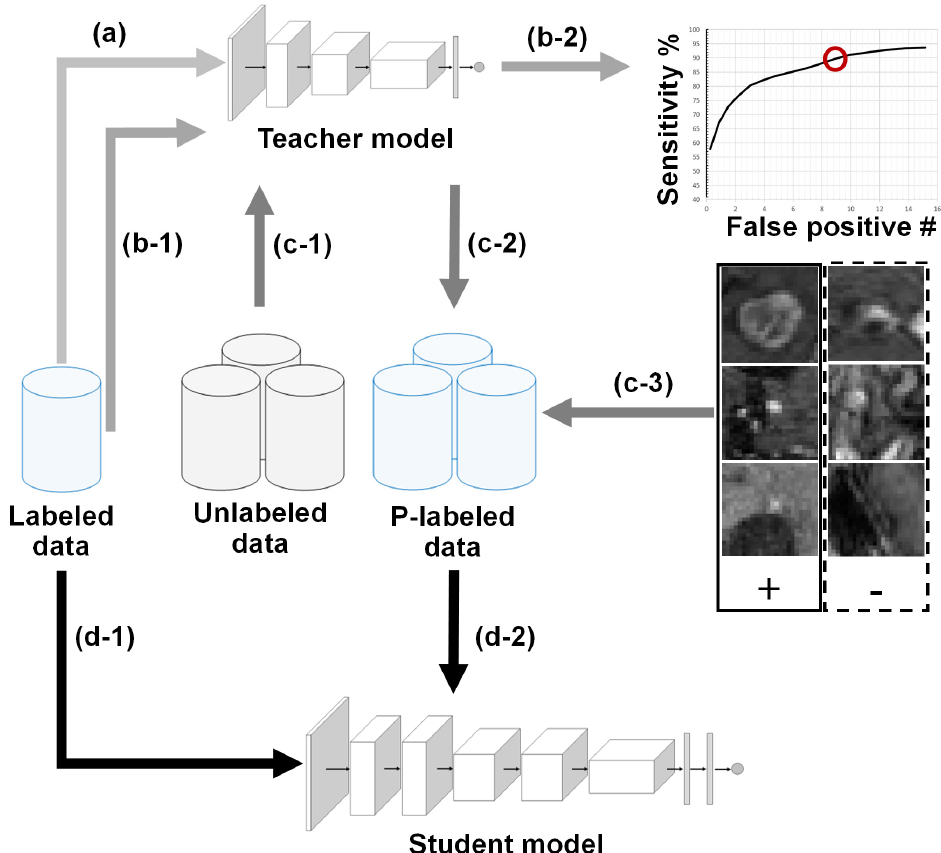
Figure 1. Adaptation of the NS-based self-training for the BM detection framework. The labeled T1c data is used for the training of a lower-capacity teacher model ( a ). Based on the labeled data ( b-1 ) and a target sensitivity ( b-2 ), the teacher model’s threshold for pseudo-labeling is determined. Via this threshold and unlabeled data ( c-1 ), the teacher model generates paired pseudo-labeled data( c-2 ). The higher-capacity student model is trained using labeled ( d-1 ) and pseudo-labeled ( d-2 ) T1c data. The training of teacher and student models could be performed iteratively, where the final student model is utilized as the deployment